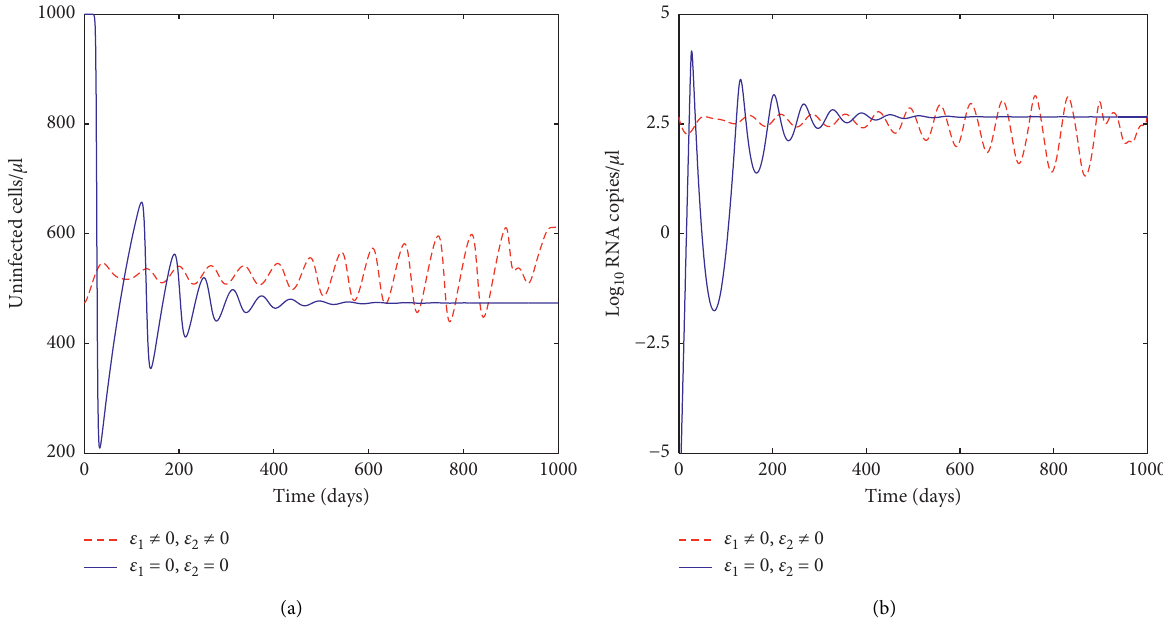
Figure 9: The level of (a) uninfected cells and (b) viral load corresponding to the optimal control strategy with ε are without control and dashed lines are with control, in which r